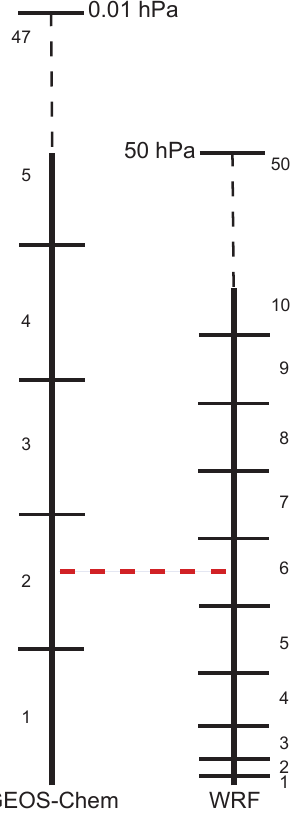
Figure 1. Conceptual illustration of the vertical mapping scheme between an example grid cell from the CMS-Flux GEOS-Chem 47-level grid ( left ) and the corresponding domain boundary grid cell in the WRF-Chem 50-level grid ( right ). Numbers indicate the levels in each model. In this case, the mass at the pressure midpoint in level 6 of the WRF column is matched to level 2 in the GEOS-Chem column. With no additional interpolation, level 6 CO 2 in the WRF column will be sourced from level 2 in GEOS-Chem (see